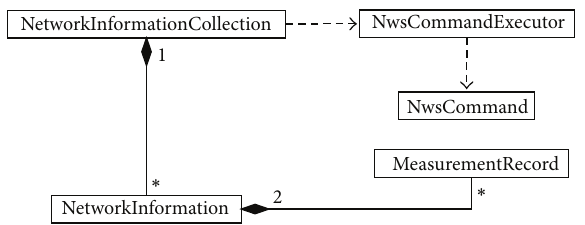
Figure1:RelationshipamongtheclassesofimplementedJavaaccess to